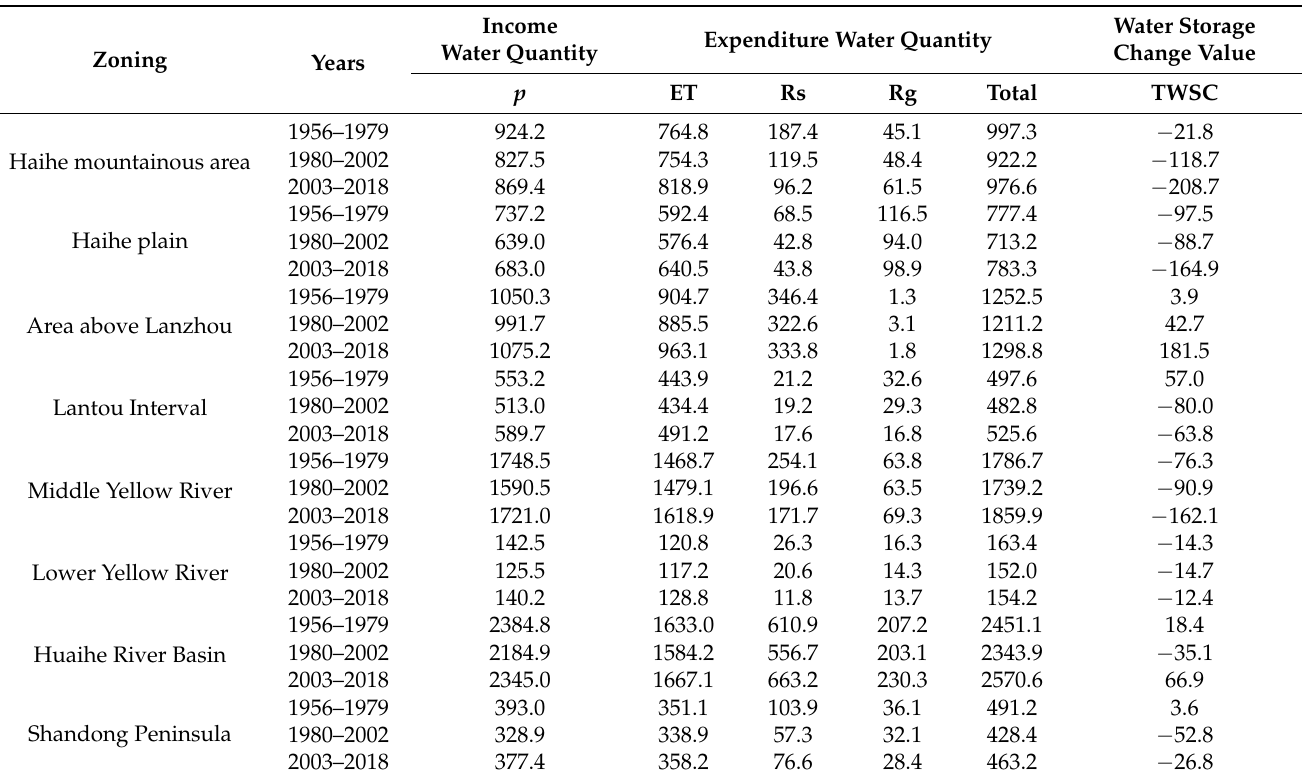
Table 4. Statistical unit of water balance entry and exit and storage variables in HRB (100 million m 3 ).